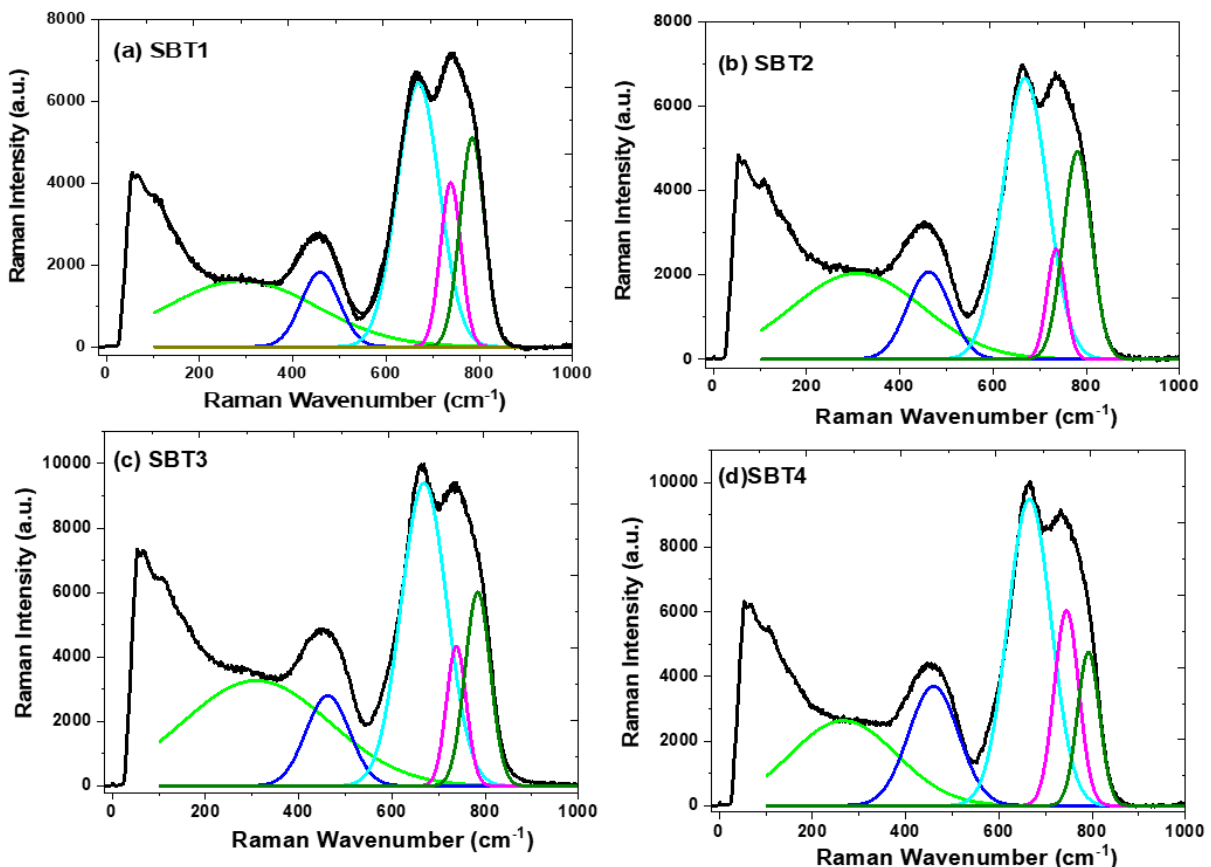
Figure 1. Deconvolution of Raman spectra in four vibration frequency regions of prepared glasses: ( a ) SBT1, ( b ) SBT2, ( c ) SBT3, and ( d ) SBT4.